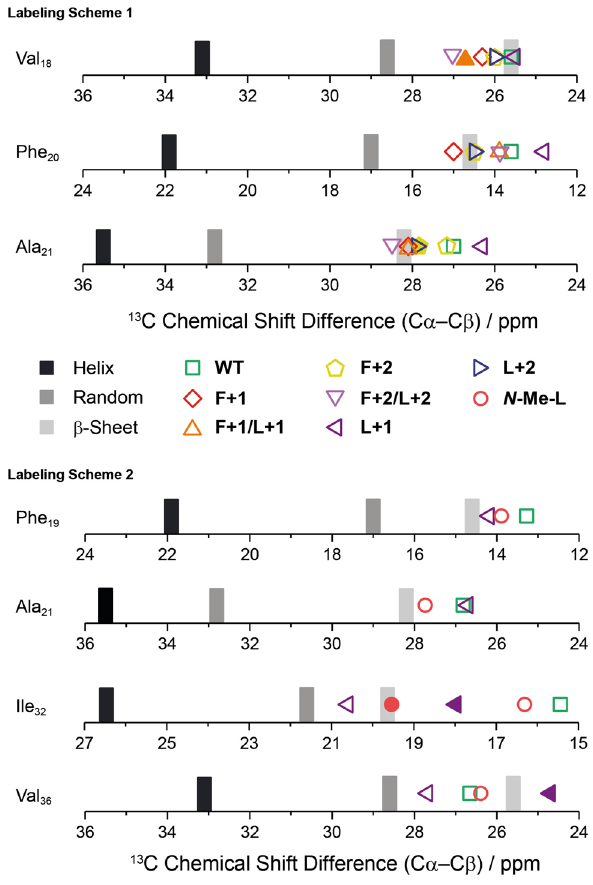
Figure 6. Overview of the 13 Cα – 13 Cβ chemical shift differences of the labeled amino acids subdivided into the two applied labeling schemes: Val 18 , Phe 20 , Ala 21 , Gly 33 (labeling scheme 1) and Phe 19 , Ala 21 , Ile 32 , Val 36 (labeling scheme 2) derived from 13 C– 13 C DARR NMR experiments. Gly 33 is not shown because it is lacking a Cβ atom. The bars represent the reference values of α-helix (black), random coil (gray) and β-sheet (light gray) secondary structure as reported in the literature 44 . Experimental data is given as varying symbols in the usual color code according to the legend. The standard error for determination of chemical shifts from 13 C– 13 C DARR NMR experiments is ± 0.5 ppm. Other conformations, if applicable, are shown as filled forms in the respective color and shape (polymorphs of Val 18 in F+1/L+1 (labeling scheme 1) are